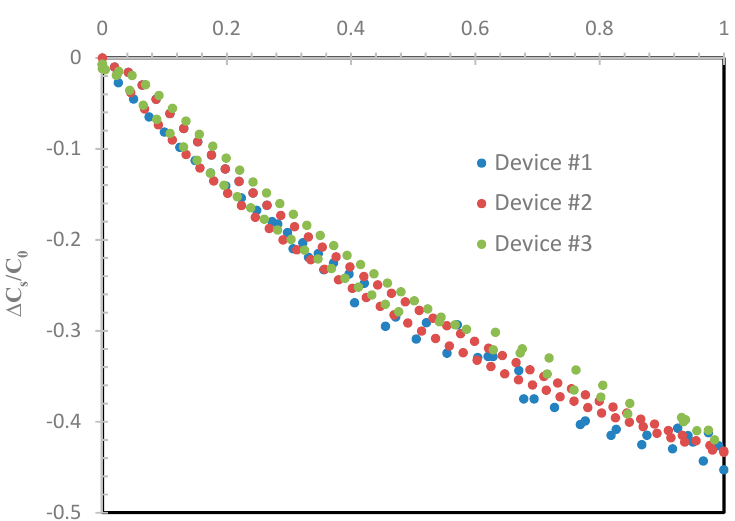
Figure 12. The worst-case Δ C S /C 0 versus strain plots of the three sensors stretched to 100% and relaxed.